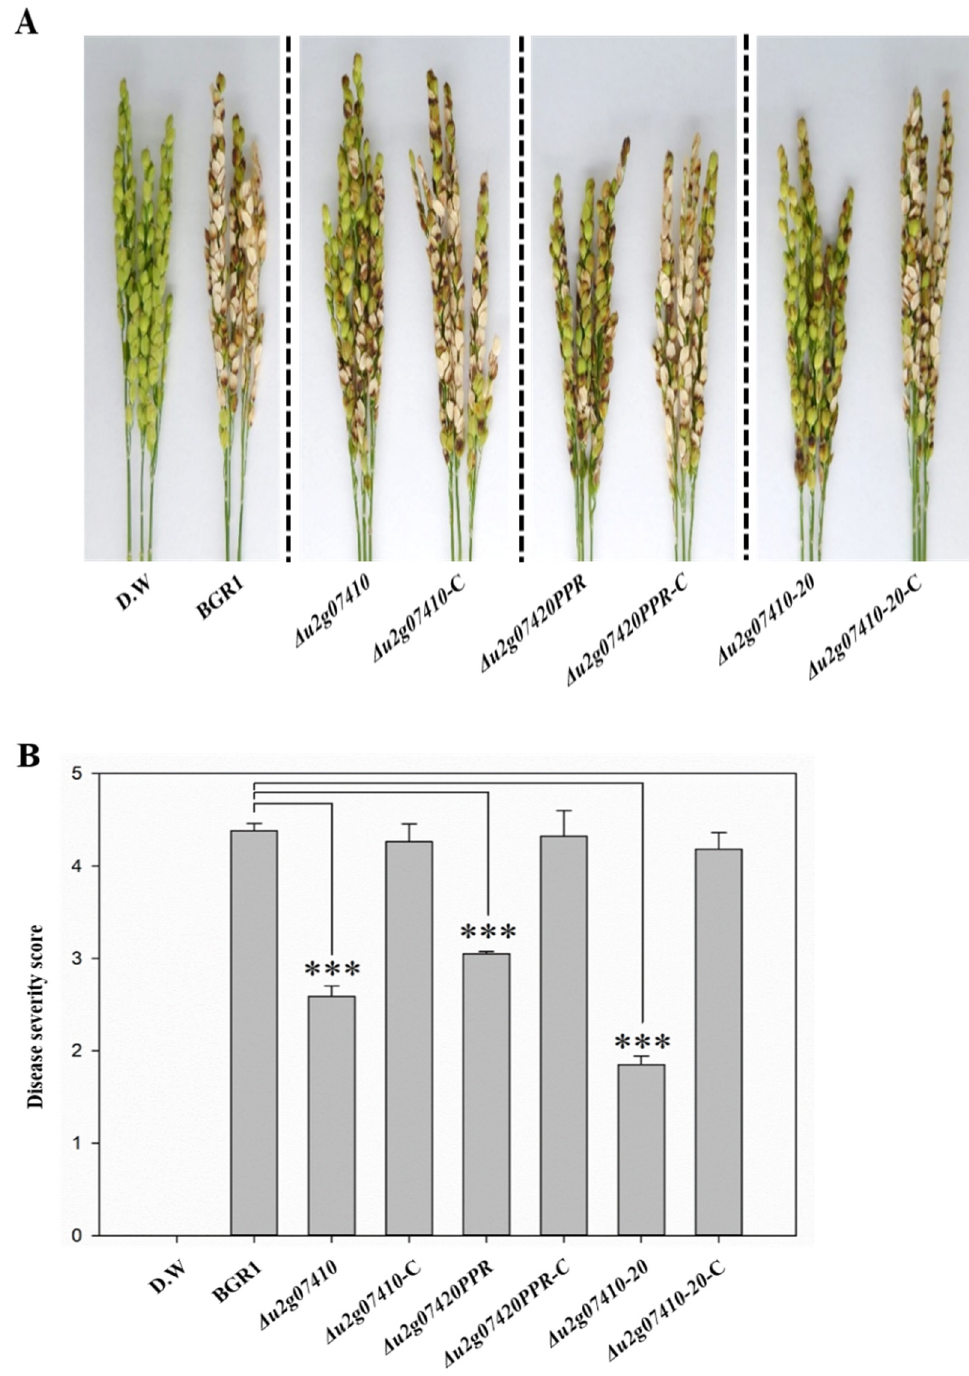
Figure 4. In vivo pathogenicity assay at the reproductive stage to assess the virulence of ∆ u2g07410 , ∆ u2g07420PPR , and ∆ u2g07410-20 . Representative of three replicates ( A ). Disease severity on the rice panicles was calculated on a scale of 0 to 5 after inoculating the bacterial suspension ( B ). Data are presented as the mean ± S.D. of three replicates ( n = 3). Mean values followed by the same letters are not significantly different according to Tukey’s HSD test (*** p < 0.001). Disease symptoms at 8 days post-inoculation. Distilled water (D.W) was used as the negative control.